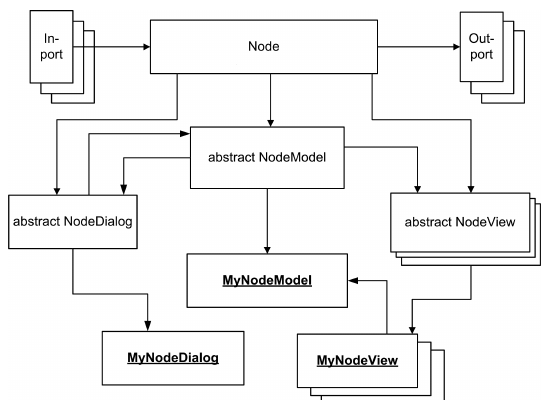
Fig. 5. A UML diagram of the Node and the main classes it relies